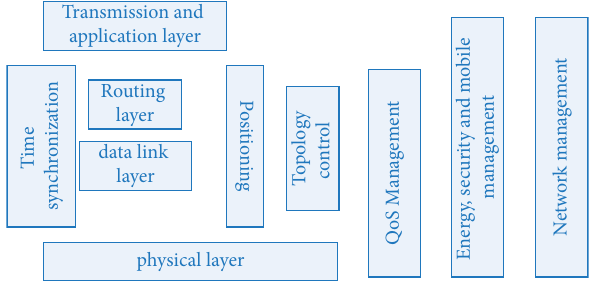
Figure 2: Wireless sensor network architecture.